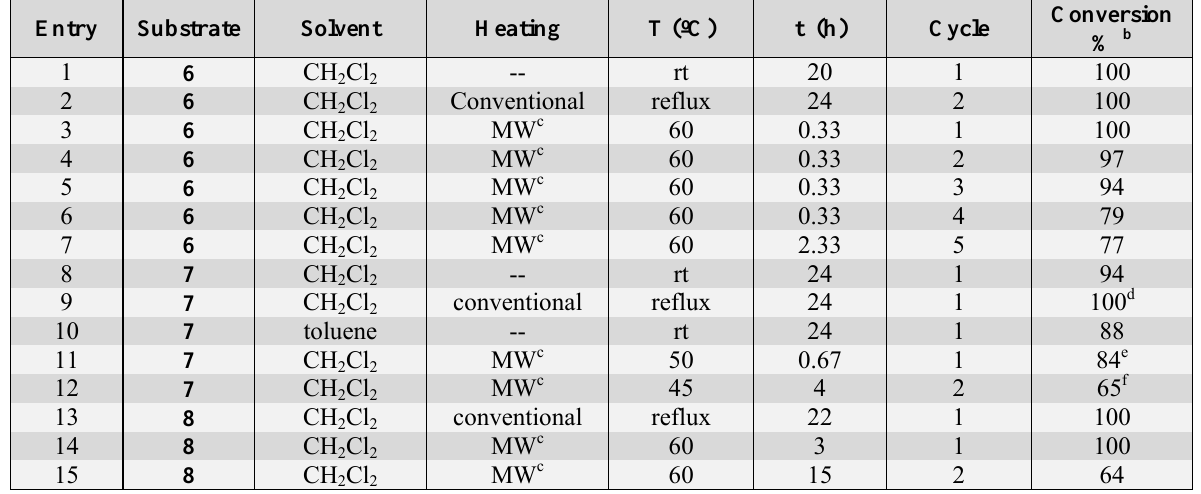
Table 1. Results for the diene and enyne RCM reactions with hybrid material M1 . a